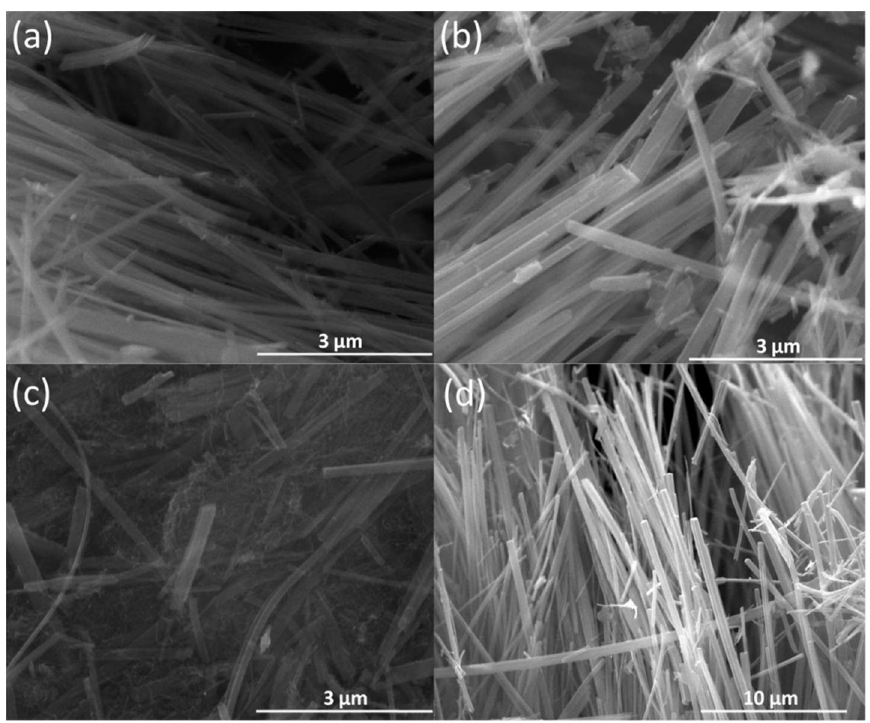
Figure 3. SEM images of V 3 O 7 · H 2 O NBs ( a ), V 3 O 7 · H 2 O / VO 2 (B)* NBs ( b ), VO 2 (B) NBs / MWCNTs ( c ) and V 2 O 5 NBs ( d ).